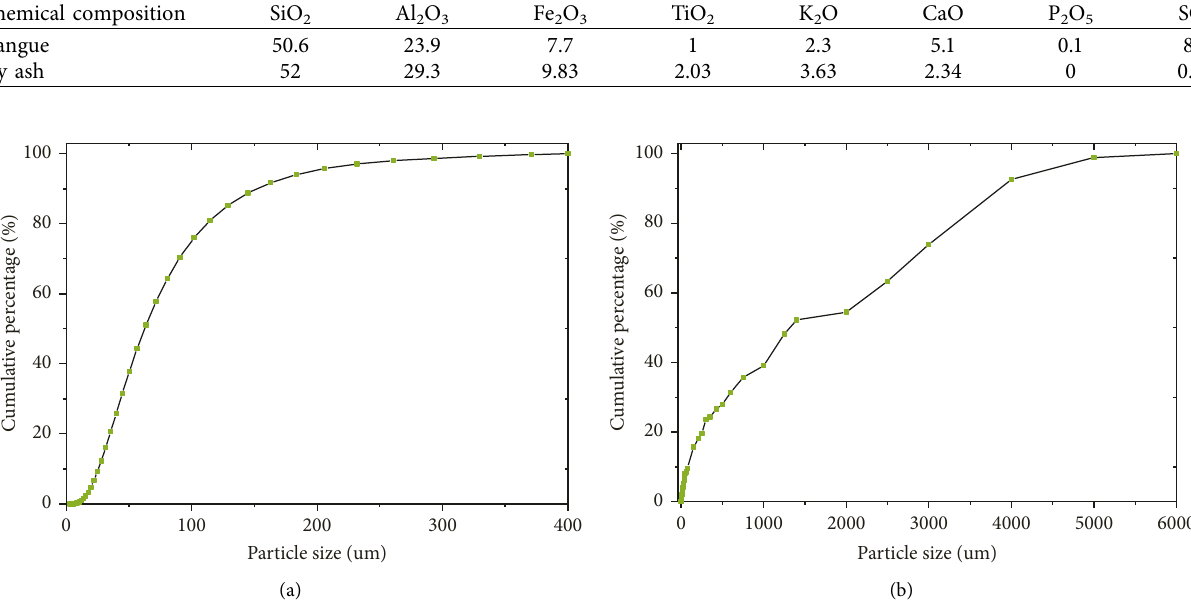
Table 1: Chemical composition of coal gangue and fly ash.